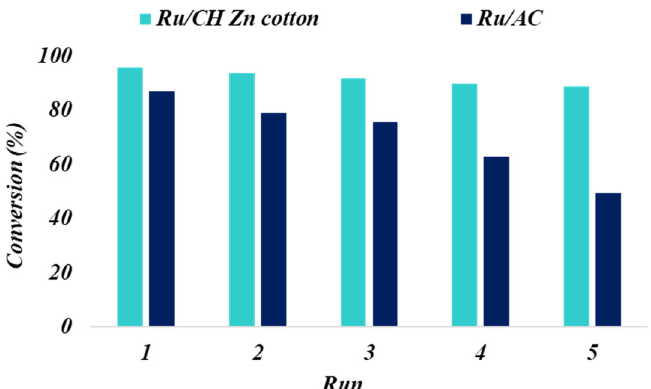
Figure 8. Catalyst recycling over Ru/C H Zn cotton and Ru/AC catalysts. Reaction conditions: 100 °C, 120